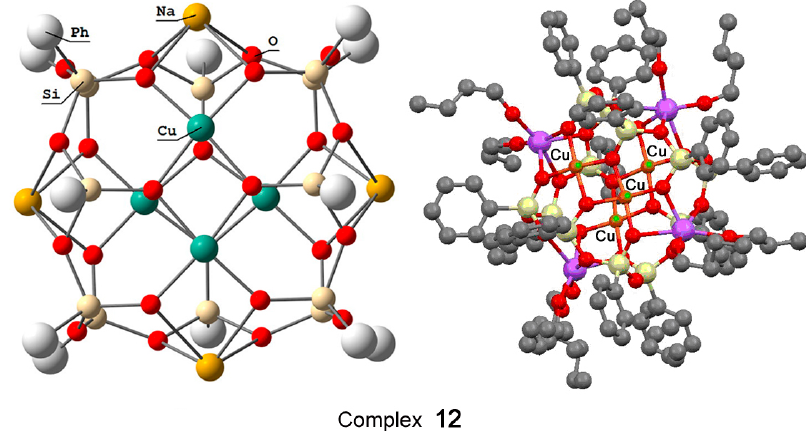
Figure 6. The structure of “Globule” ‐ like compound [(PhSiO 1.5 ) 12 (CuO) 4 (NaO 0.5 ) 4 ] ( 12 ). Adapted from Ref. [222 ] .